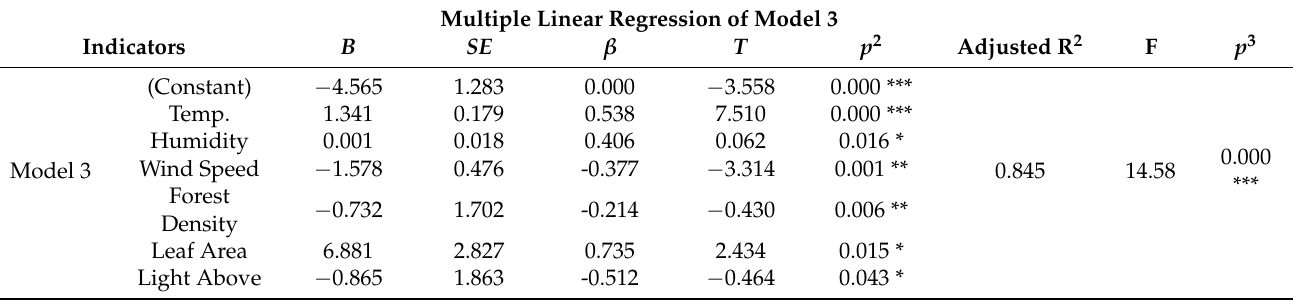
Table 6. Results of regression analysis based on selected visual and AMOS indicators. Multiple Linear Regression of Model